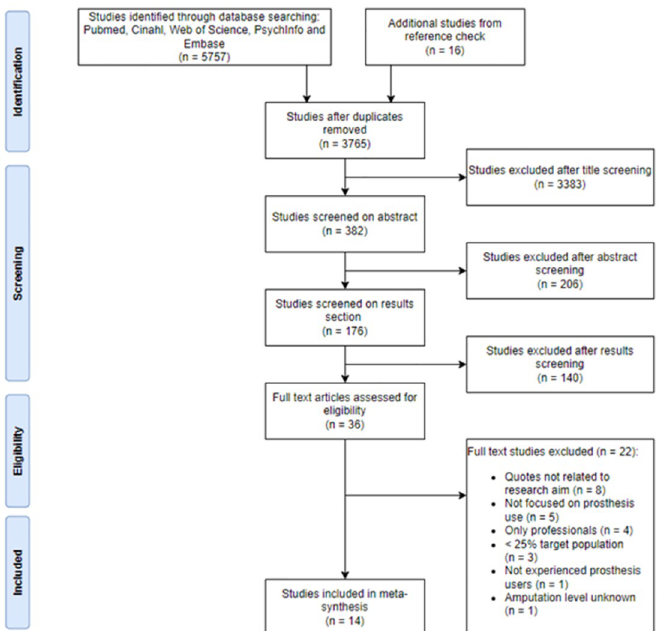
Fig 1. Preferred Reporting Items for Systematic Reviews and Meta-Analysis (PRISMA) flowchart for study selection.